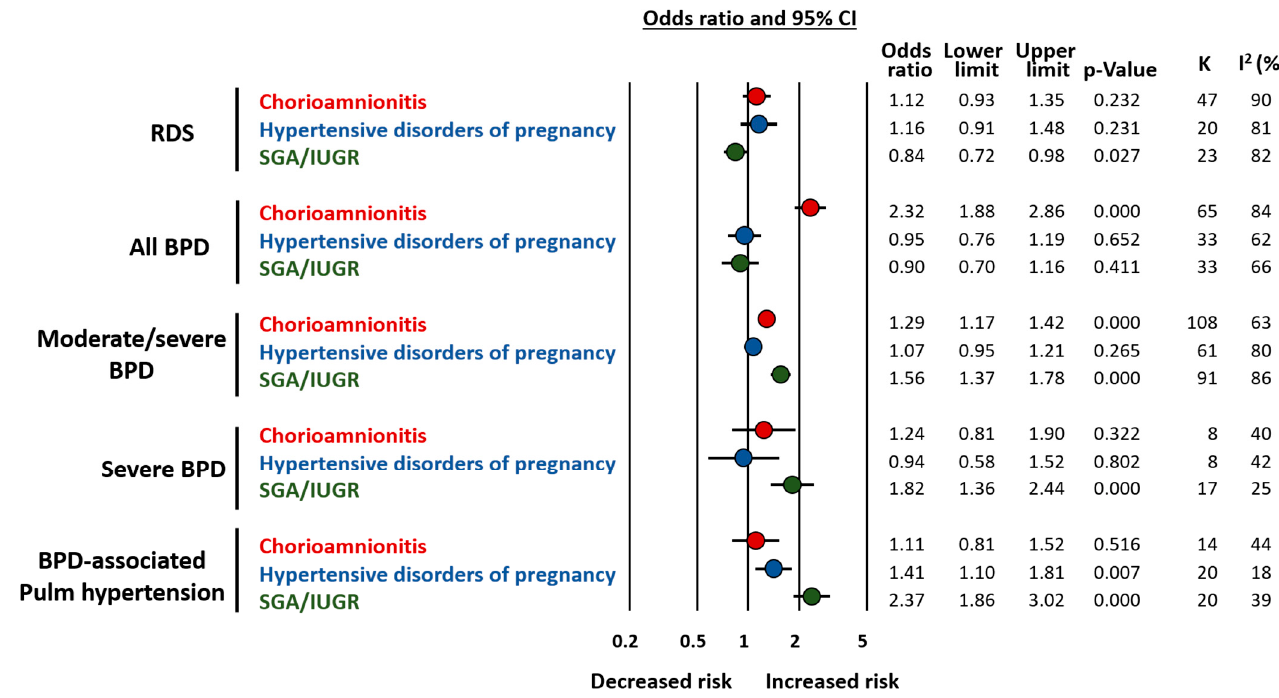
Figure 3. Summary of meta-analyses on the association between endotype of prematurity and short- term respiratory complications. Based on References [47,48]. Abbreviations: Respiratory distress syndrome (RDS), bronchopulmonary dysplasia (BPD), small for gestational age (SGA), intrauterine growth restriction (IUGR), confidence interval (CI).